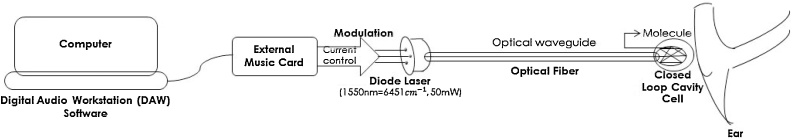
Preliminary conceptual photoacoustic based earphone design.